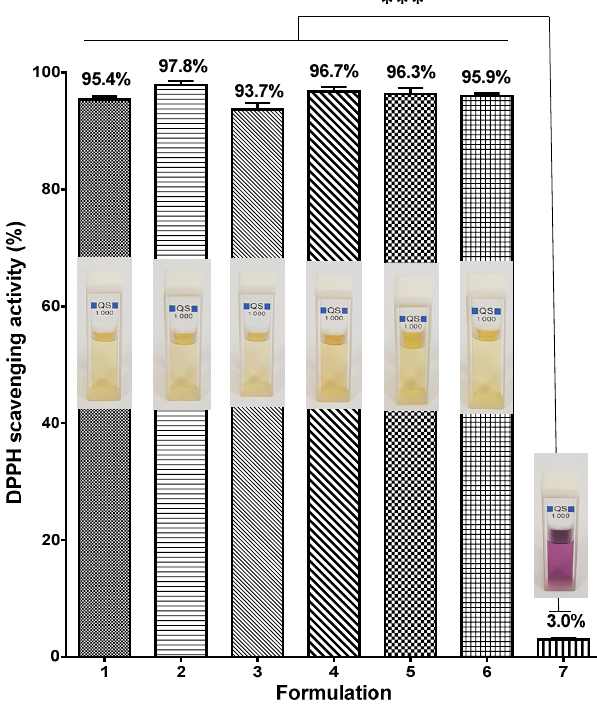
Figure 7. Antioxidant activity of: (1) ethanol solution of QUE, (2) ethanol solution of RUT, (3) CA/PEG/QUE fibers, (4) CA/PEG/RUT fibers, (5) CA/PEG/QUE/RUT fibers, (6) CA/PEG/QUE+CA/PEG/RUT fibers, (7) CA/PEG fibers. *** p <0.001. Photos of the corresponding solutions are presented as digital images.